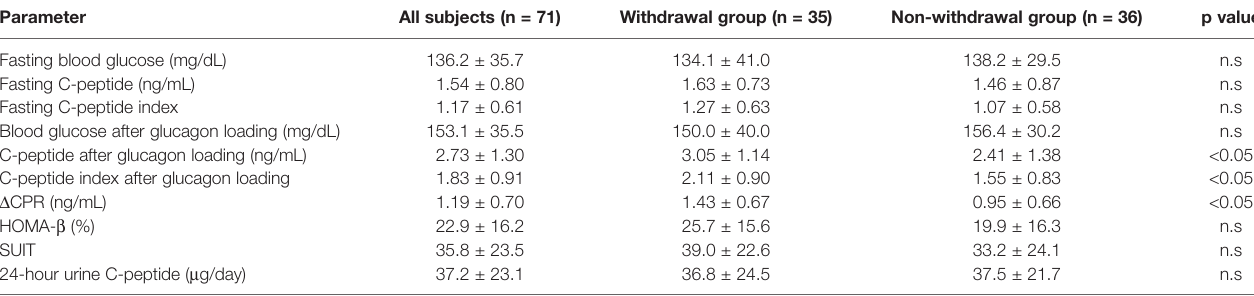
TABLE 2 | Various parameters of endogenous insulin secretory capacity in this study participants. Parameter